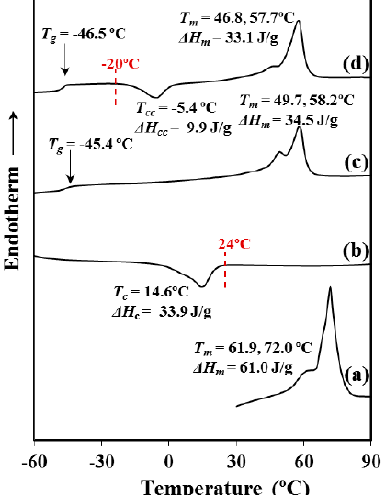
Figure 1. Sequence of calorimetric and heating runs performed with the initial commercial suture of poly(4-hydroxybutyrate (P4HB): ( a ) First heating run performed at 10 °C/min; ( b ) Cooling run at 10 °C/min after keeping the sample in the melt state for one min; ( c ) Heating run at 10 °C/min of the above melt crystallized samples and ( d ) Heating run at 10 °C/min of a sample quenched from the melt at the maximum rate allowed by the equipment.